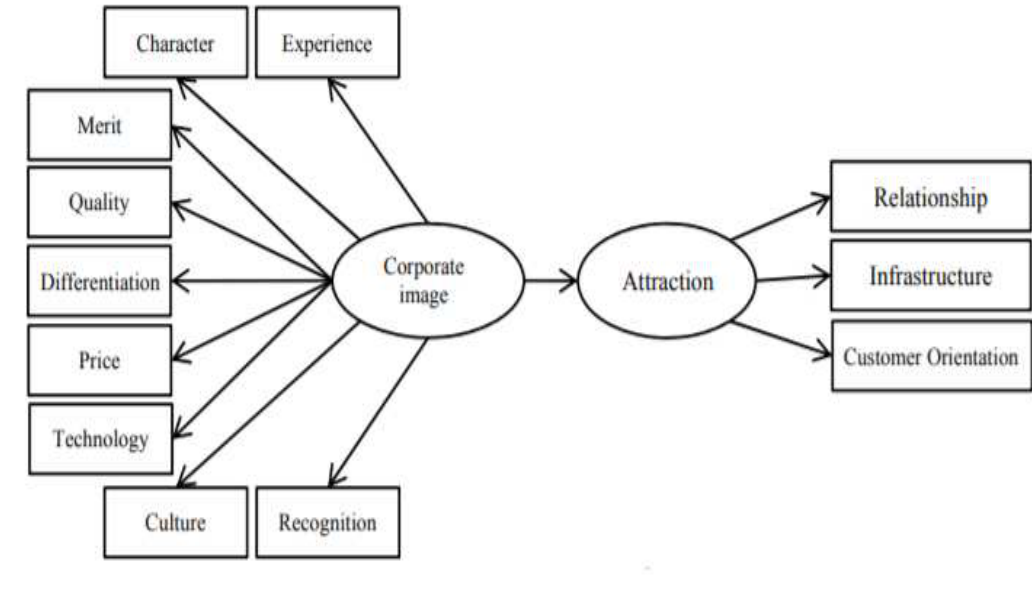
Fig. 3. Relationship between corporate image components and customer attraction Source: Gouji, Taghvaei, and Soleimani (2016) .